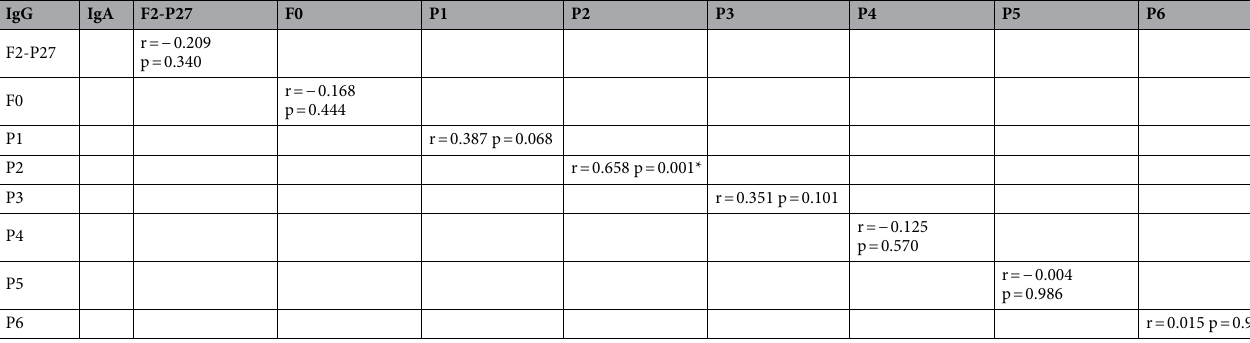
Table 1. Correlations between IgG and IgA levels to F2-P27, F0 and F2-derived peptides. Spearman correlation r; *p values less than 0.05 were considered as significant.